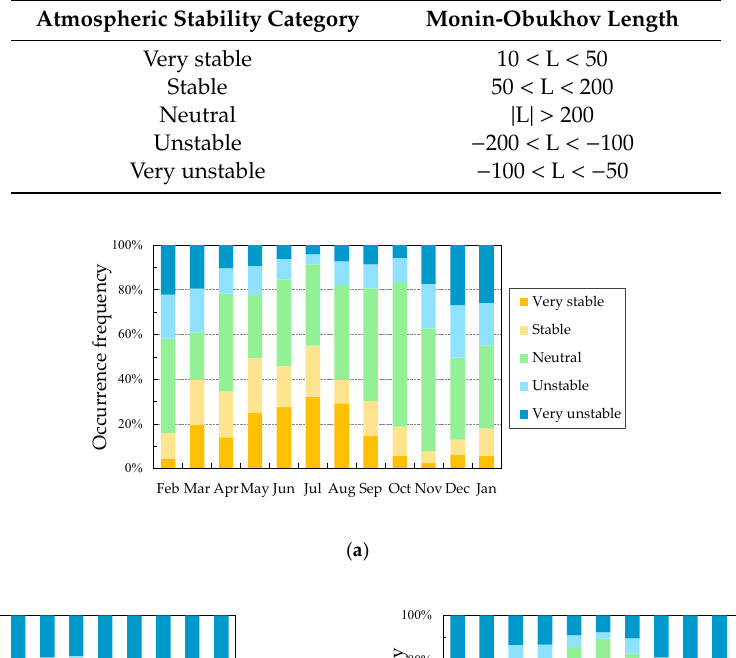
Table 8. Classification of atmospheric stability according to Monin-Obukhov length intervals.